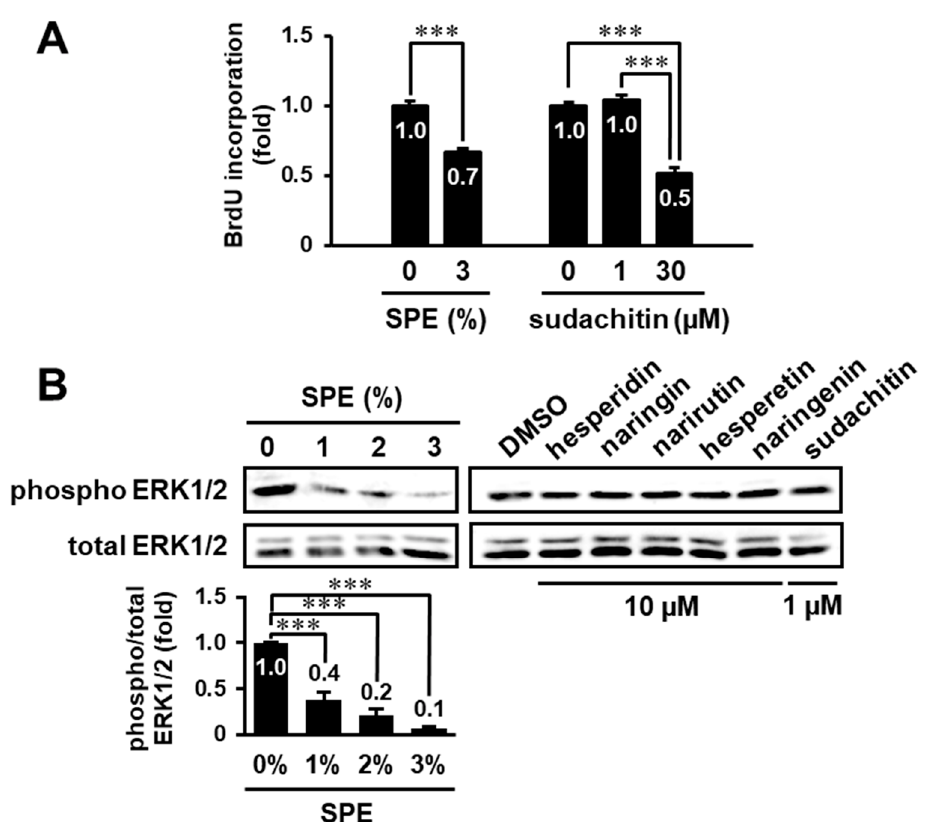
Figure 5. Effects of some phenolic compounds on cell proliferation and ERK1/2 phosphorylation in higher concentrations than those in the extract of C. sudachi peels. ( A ) Serum-starved HaCaT cells were pretreated with SPE (3%) or sudachitin (1 or 30 μ M) for 1 h and subsequently incubated in the presence of 3% FBS. After 24 h, the cells were subjected to a BrdU incorporation assay. ( B ) HaCaT cells were treated with either 0 – 3% SPE, dimethyl sulfoxide (DMSO), 10 μ M hesperidin, 10 μ M naringin, 10 μ M narirutin, 10 μ M hesperetin, 10 μ M naringenin, or 1 μ M sudachitin for 1 h. Then, the cell lysates were prepared and immunoblotted with anti-ERK1/2 and anti-phospho-ERK1/2 antibodies. The levels of phosphorylated ERK1/2 were normalized to the levels of the total ERK1/2. All experiments were performed multiple times with similar results. The data are expressed as the mean ± SE derived from at least three independent experiments, and statistical analysis was performed by ANOVA with Bonferroni’s multiple comparisons test; *** p < 0.001.